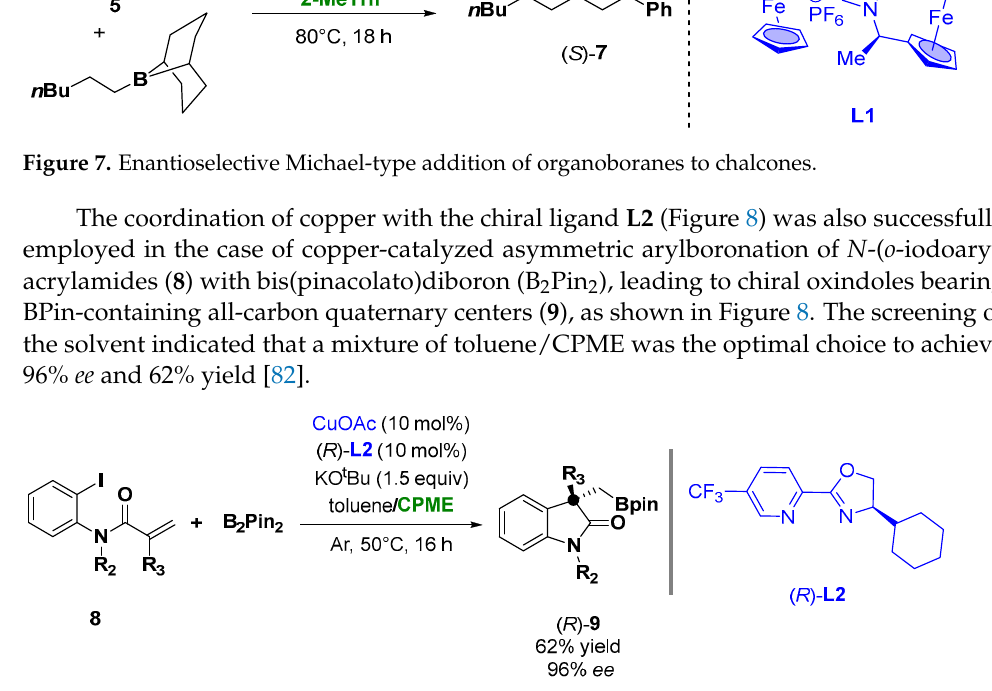
Figure 8. Asymmetric α -borylmethyl oxindoles from o -iodoanilides.